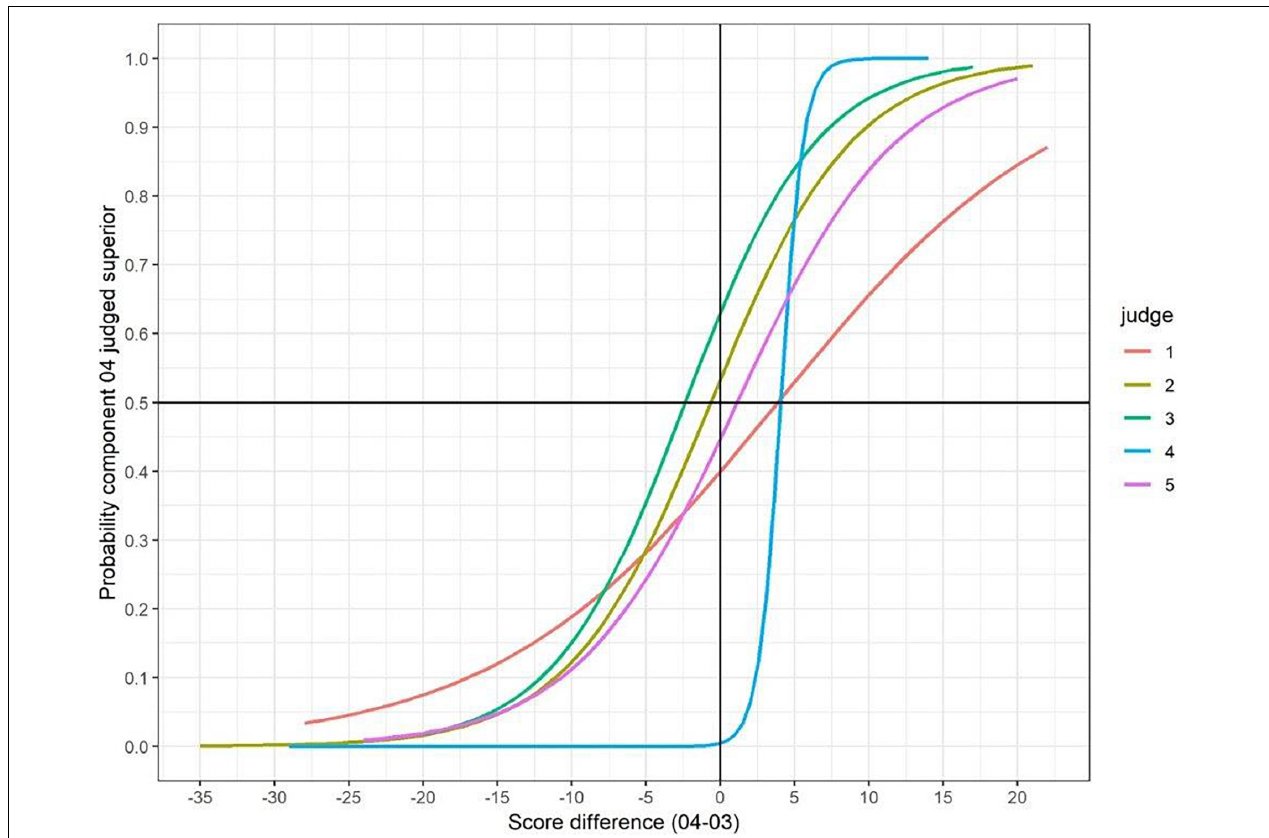
FIGURE 5 | The relationship between differences in marks for a pair and the likelihood of selecting component 04 as superior (by